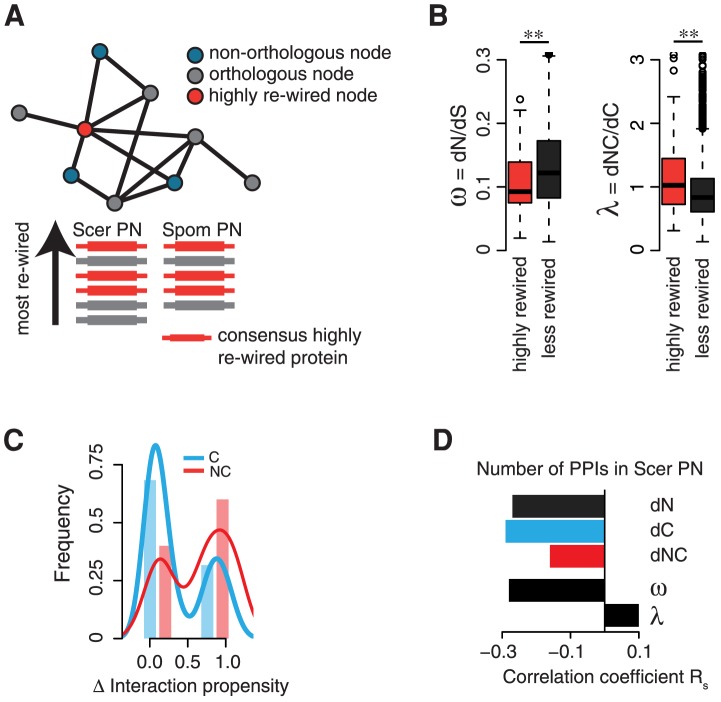
λ describes the re-wiring of protein-protein interactions.
A The most highly re-wired proteins are derived from a consensus ranking of nodes with the most non-orthologous neighbors in the protein interactions networks (PN) of S. cerevisiae (Scer) and S. pombe (Spom). B Highly re-wired proteins evolve at lower ω, thus are under stronger purifying selective pressure, but evolve at clearly higher λ compared to less rewired proteins. C NC mutations are much more likely to comprise changes between amino acids with very different interaction propensities than C mutations. Shown are the distributions of the changes in interaction propensity of NC and C mutations (lines), and a simpler binary classification into high and low differential interaction propensities (bars, more transparent in the background). D The number of protein-protein interactions (PPIs) negatively correlates more strongly with dC than dNC, and only weakly with λ, suggesting that λ is not systematically biased by high connectivity in protein networks. Statistical significance is indicated as ** (p<0.01).